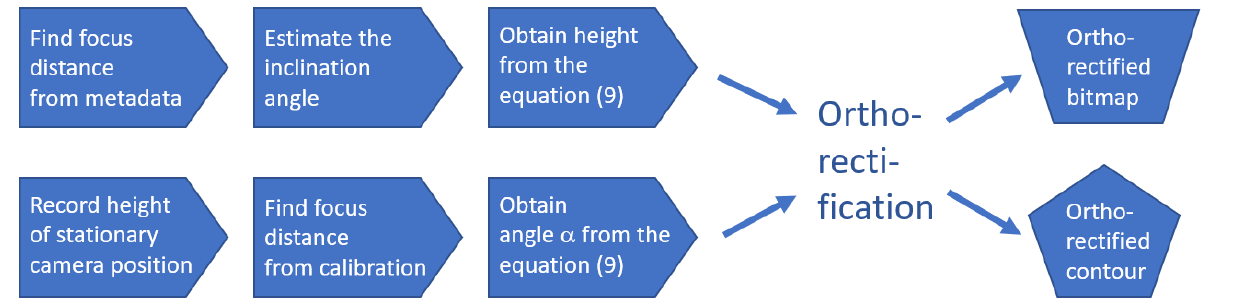
Figure 5. The steps taken for orthorectification of the images from hand and stationary